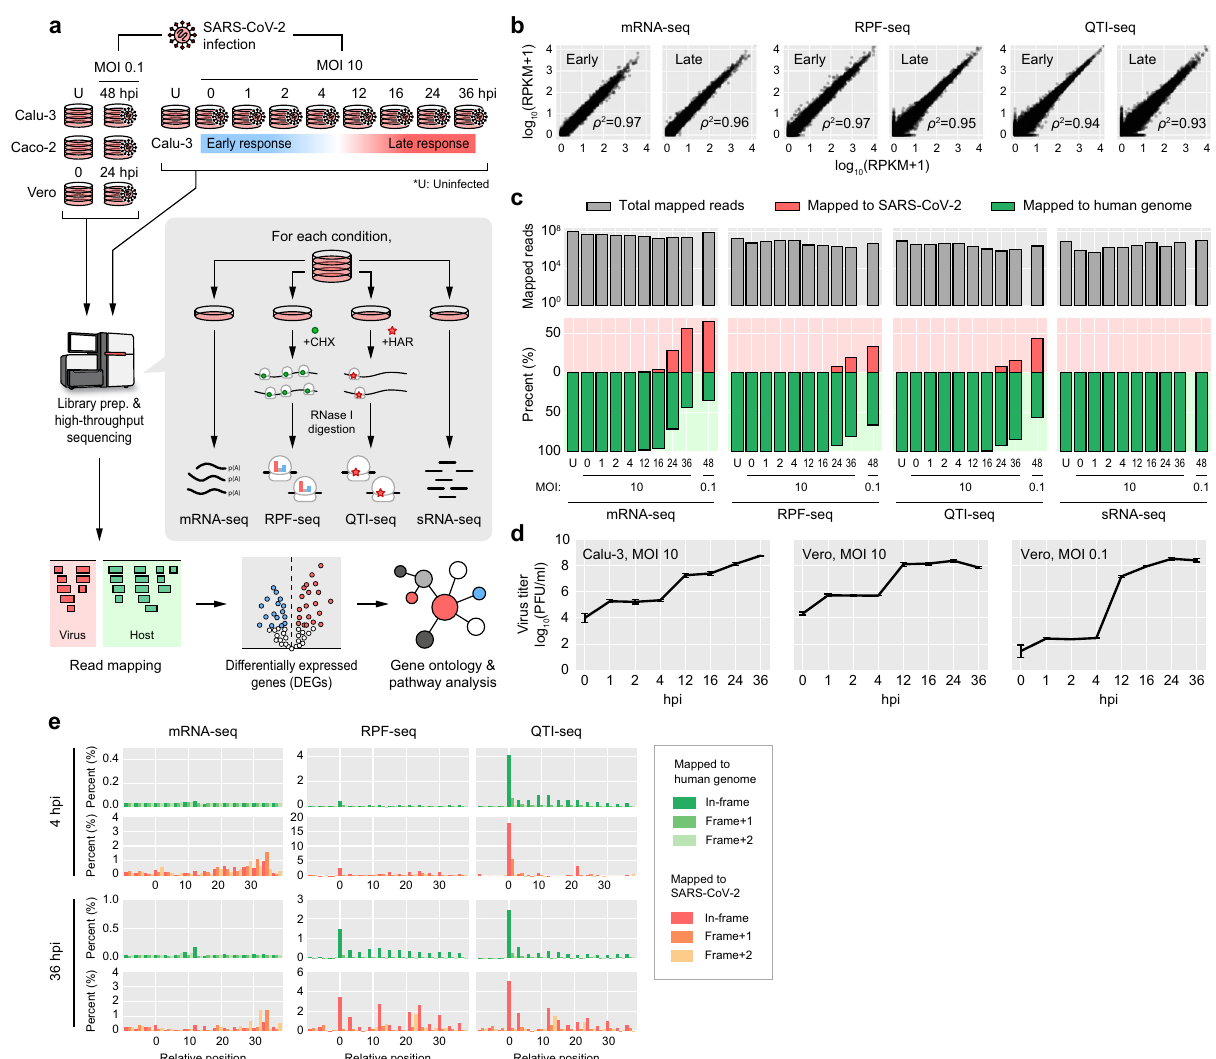
Fig. 1 Experimental design and generation of massive-scale datasets. a Overall design of the study. A fi ne-scale temporal atlas of the SARS-CoV-2 translatome and transcriptome was constructed for early (0, 1, 2, and 4) and late (12, 16, 24, and 36) hours post infection (hpi) at multiplicity of infection (MOI) of 10 and at 48 hpi (MOI = 0.1) in Calu-3 and Caco-2 cell lines and at 24 hpi (MOI = 0.1) in Vero cell line. The temporal atlas of the human translatome and transcriptome in response to SARS-CoV-2 invasion were also constructed. Ribosome-protected mRNA fragment sequencing (RPF-seq), quantitative pro fi ling of initiating ribosomes sequencing (QTI-seq), mRNA sequencing (mRNA-seq), and small RNA sequencing (sRNA-seq) were performed for each time point. For more details, see “ Methods ” . b High reproducibility between the replicates of sequenced data. Correlation coef fi cient (Spearman ’ s ρ ) was calculated by comparing host gene expression levels between replicates. Both x - and y -axes represent log 10 (RPKM + 1). Representative examples from early and late hpi are displayed. For a full version, see Supplementary Fig. 1b, c. c The number of total mapped reads are shown in log 10 scale (top) with the relative fraction of reads mapped to the human and SARS-CoV-2 genomes (bottom). The upward and downward directions of the y -axis indicate the fraction of the reads mapped to the SARS-CoV-2 and human genomes, respectively. d A growth dynamics curve of SARS-CoV-2 in Calu-3 and Vero cell lines after infection. The mean values ±95% con fi dence intervals are displayed ( n = 3 biological independent experiments). e Distribution of mRNA-seq (left), RPF-seq (middle), and QTI-seq (right) reads with respect to the relative position near the start of ORF. For 4 and 36 hpi, the 13th nucleotide position (12-nt offset from the 5 ′ end) of the reads mapped to human (green) or SARS-CoV-2 (red) was counted for each sequencing data. The relative fraction to the amount of reads mapped to the entire ORF was calculated for each position, and the y -axis represents the average of the relative fractions for ORFs with >50 reads mapped. Open reading frames are depicted as three different colored bars with the darkest bars indicating in frame and the others out of